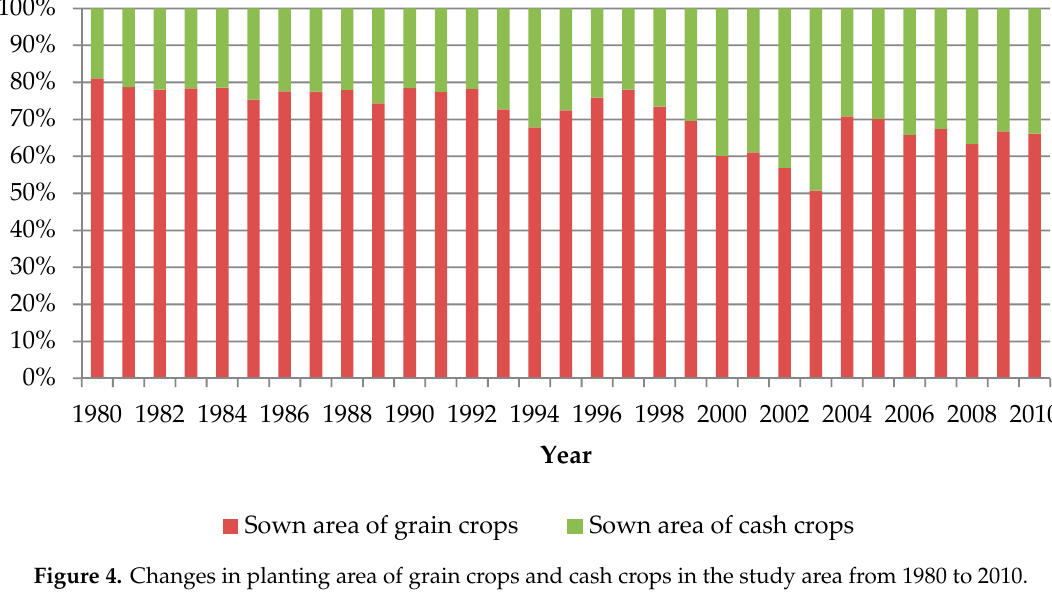
Figure 4. Changes in planting area of grain crops and cash crops in the study area from 1980 to 2010.